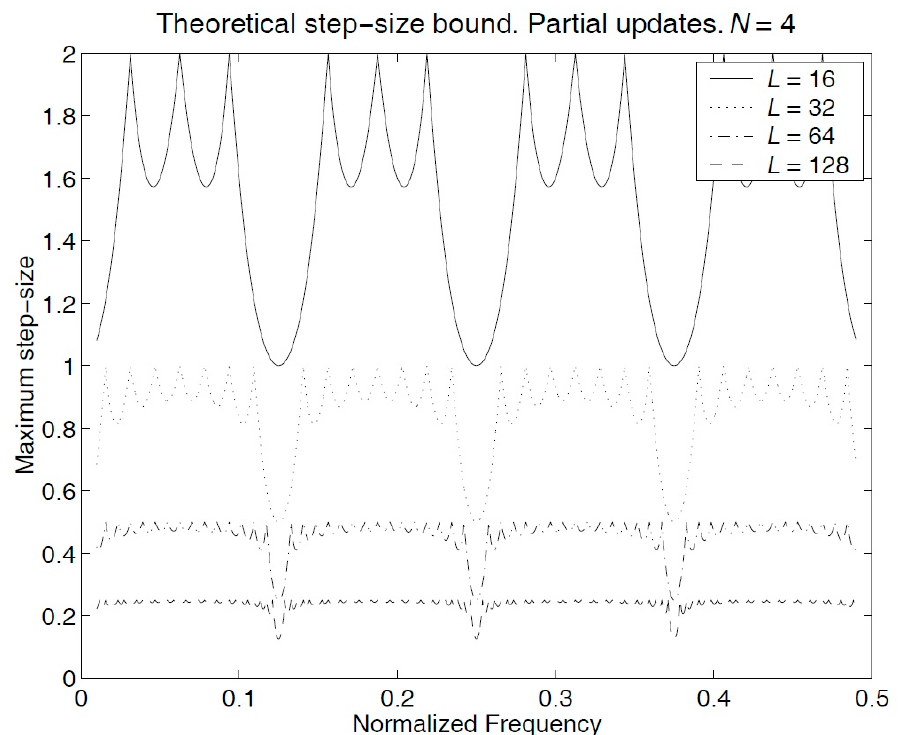
Figure A3. Step-size bound of the sequential PU LMS algorithm with decimation factor N = 4 for different filter lengths, L = 16, 32, 64, and 128. The input vector is an N -decimated single tone whose normalized frequency varies from 0 to 0.5.